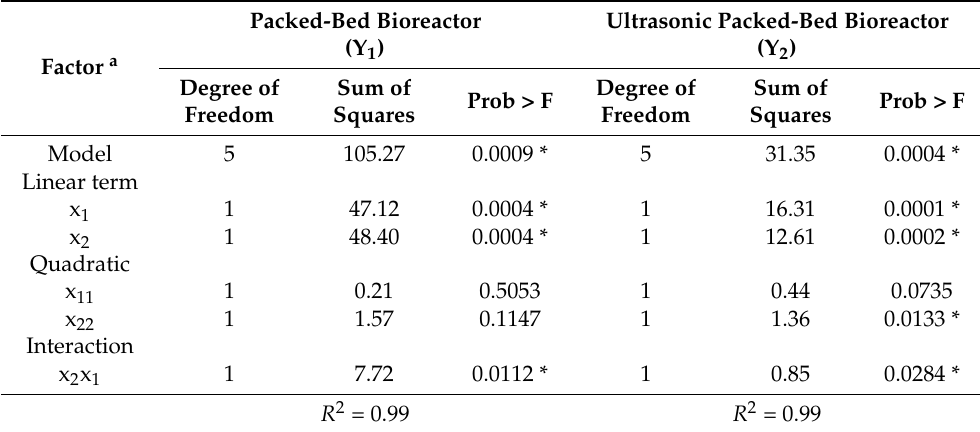
Table 2. Analysis of variance (ANOVA) analysis for continuous lipase-catalyzed synthesis of DHA + EPA ethyl ester by packed-bed bioreactor and ultrasonic packed-bed